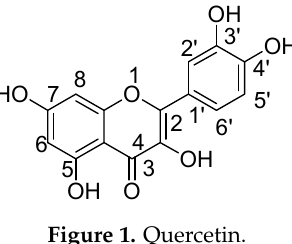
Figure 1. Quercetin.